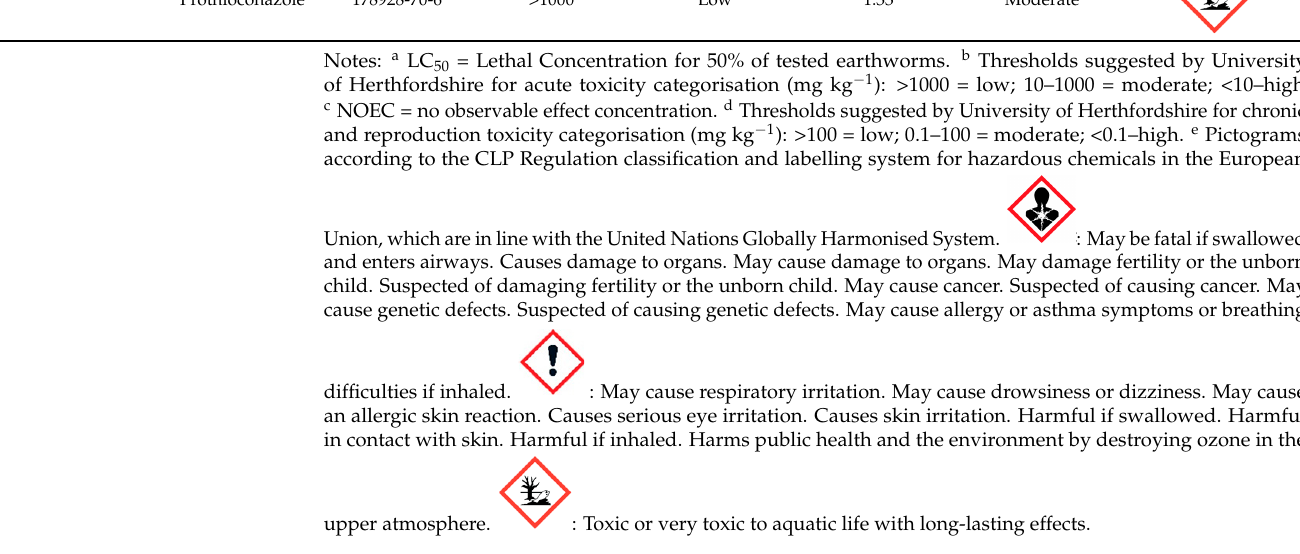
Table 4. The hazards of other ingredients declared in two commercial fungicide